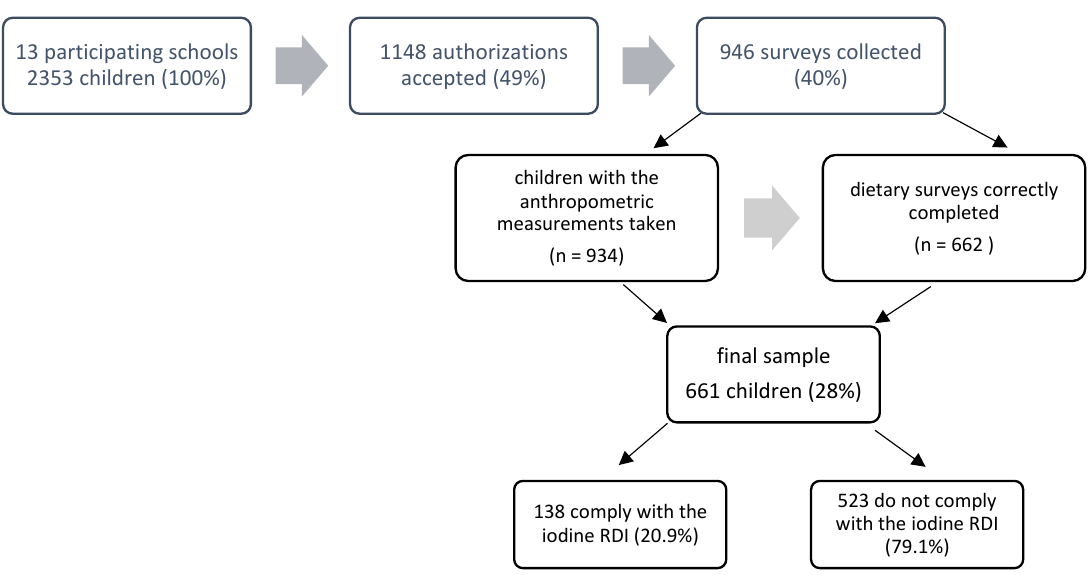
Figure 1. Flow diagram of the study population. RDI: Recommended Daily Intake.